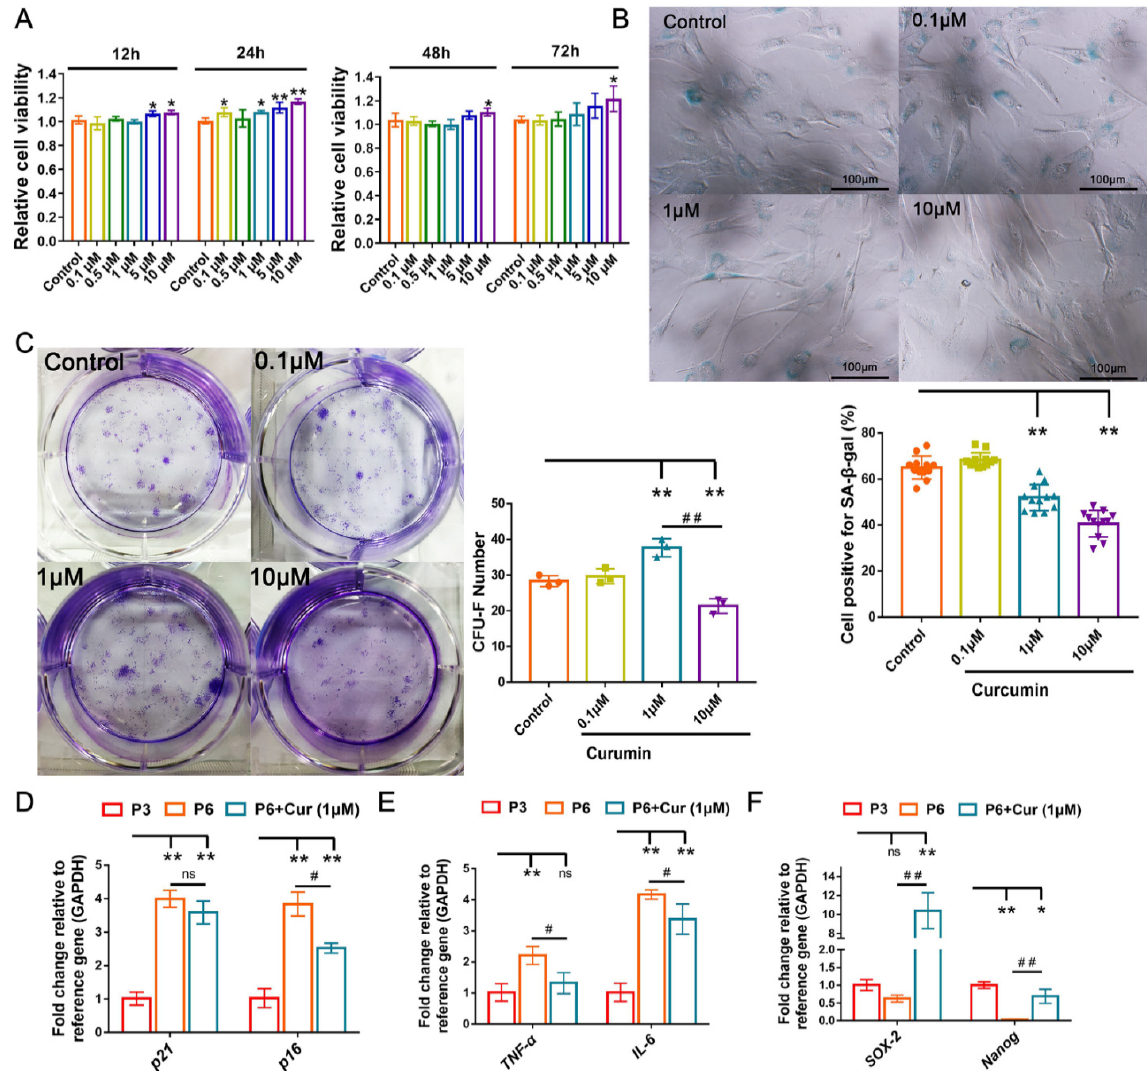
Figure 3. Effects of Cur on senescent cBMSCs (P6). ( A ) Effect of Cur on the viability of cBMSCs. Effects of different doses (0.1, 0.5, 1, 5, and 10 μ mol/L) and time points (12 h, 24 h, 48 h, and 72 h) of the responses of Cur on the viability of P6 cBMSCs were evaluated using a CCK-8 assay. ( B ) SA- β -gal expression levels in the P6 cBMSCs in the absence (control) or presence of Cur (0.1, 1, and 10 μ mol/L) for 24h; scale bars = 100 μ m. ( C ) The rate of colony formation in CFU-F after treatment with Cur for 24 h. The expression of senescence-related genes of p21 and p16 ( D ), pro-inflammatory cytokines genes TNF- α and IL-6 ( E ), and stemness markers Nanog and SOX-2 ( F ), as measured by RT-qPCR. The values are the means ± SDs of triplicate experiments. Gene expression was normalized relative to the expression of the GAPDH . * p < 0.05, ** p < 0.01 compared with the control group. # p < 0.05, ## p < 0.01 for intragroup comparisons.